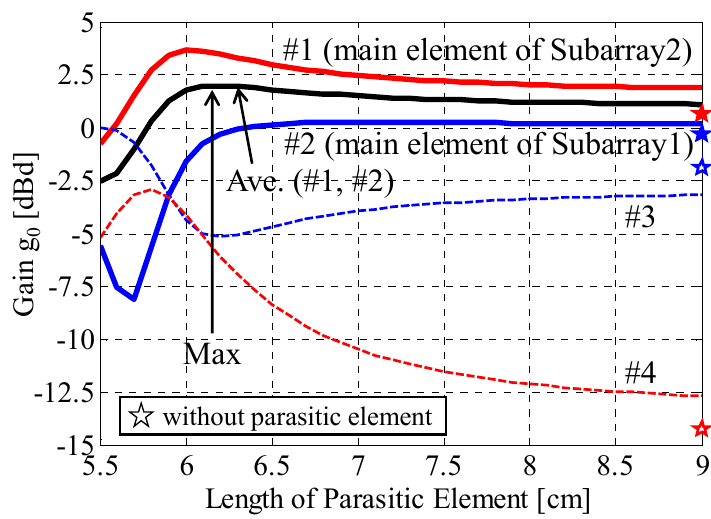
Figure 9. Radiation gain of each element.